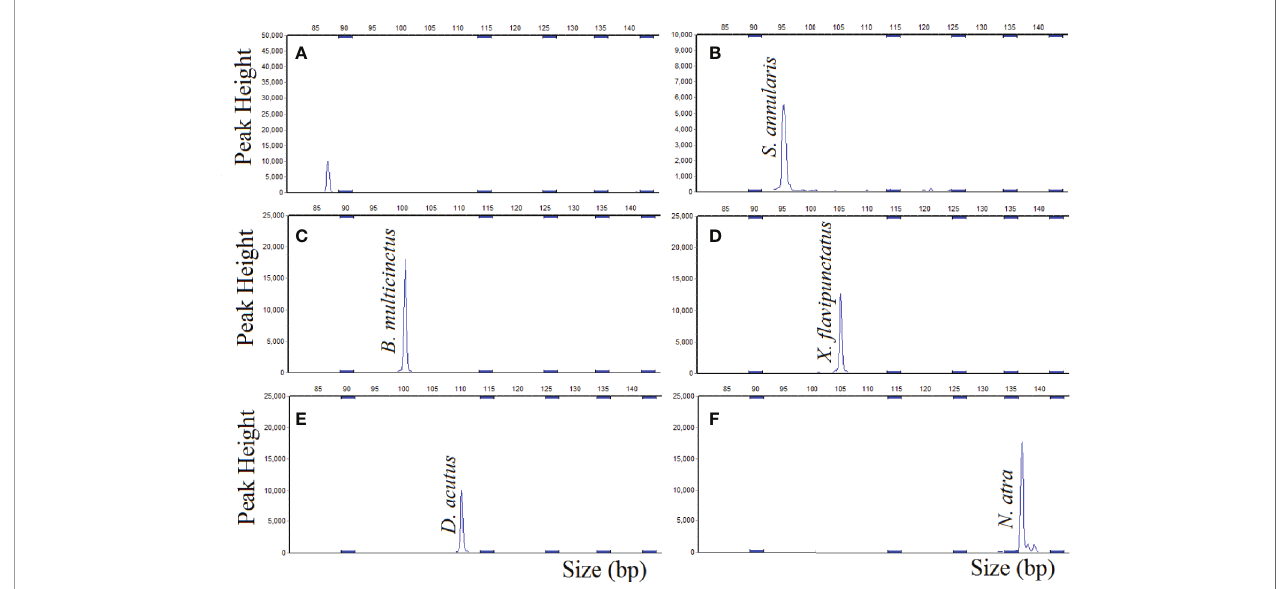
FIGURE 2 | MLPA single probe speci fi city, DNA target hybridized with single probe. (A) negative control; (B) S. annularis ; (C) B. multicinctus ; (D) X. fl avipunctatus ; (E) D. acutus ; (F) N. atra .